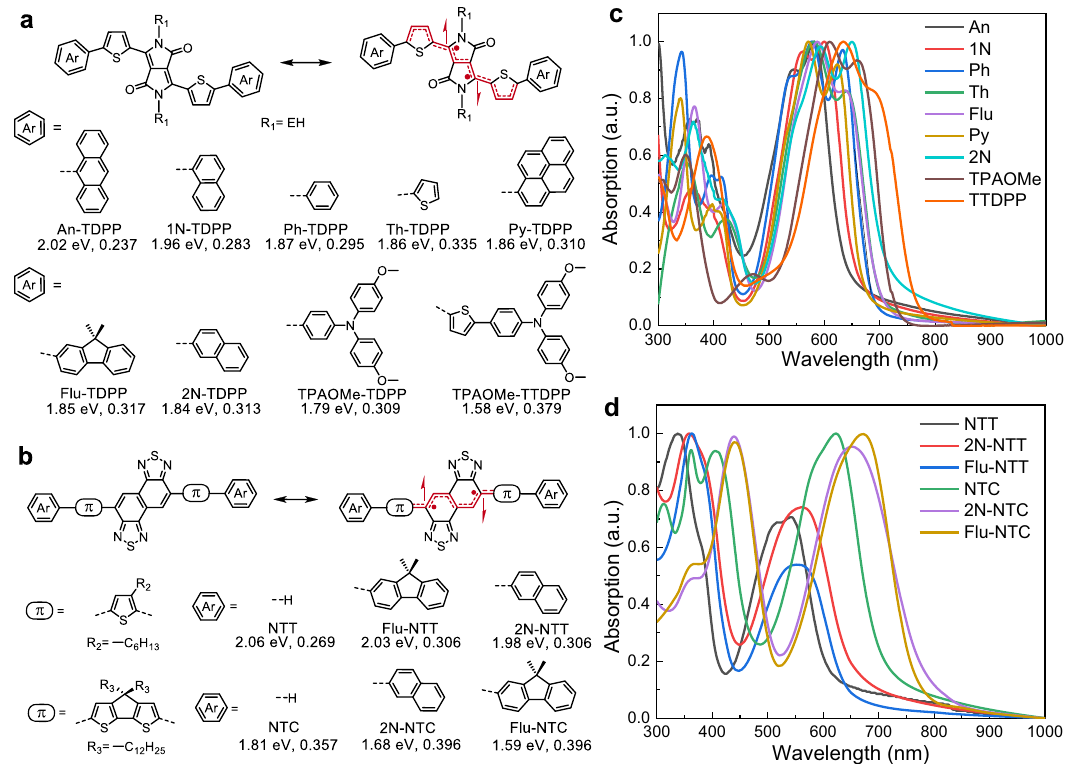
Fig. 2 Molecular structures and thin- fi lm absorption pro fi les of donor-acceptor-donor small molecules containing TDPP, NTT, and NTC cores. a , b Molecular structures of the DPP and NT-based small molecules with variations of the donor moieties. The optical bandgap ( E g opt ) as determined from the intersection of absorbance and emission curves of the thin- fi lms and calculated y 0 at the PUHF/6-31 G( d,p ) level of theory, are listed beneath the donor units. c , d Absorption spectra of thin- fi lms cast from chloroform onto quartz